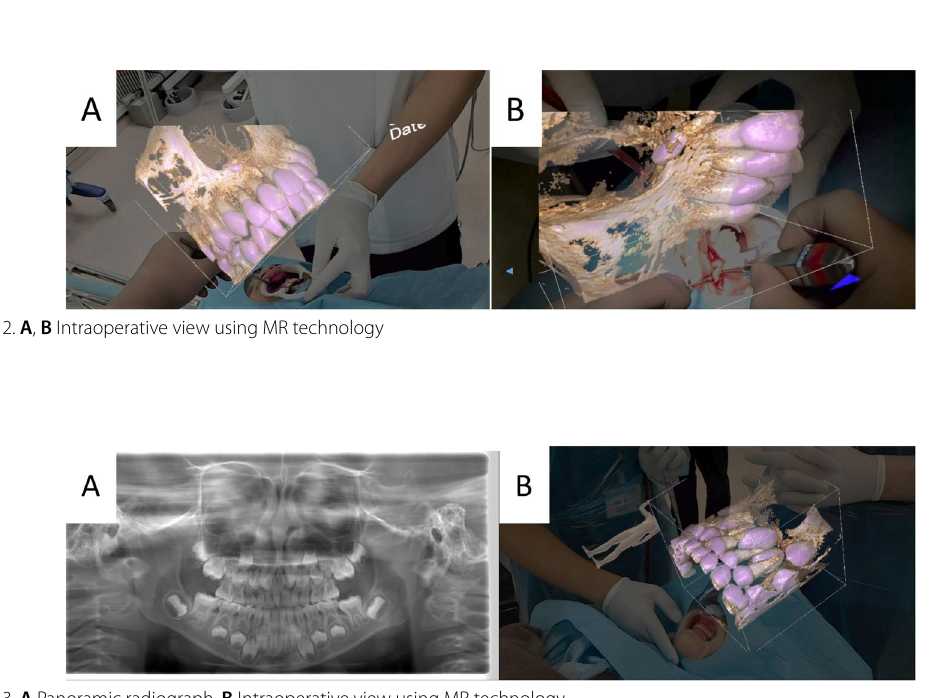
Fig. 5 Case 3. A Panoramic radiograph. B Intraoperative view using MR